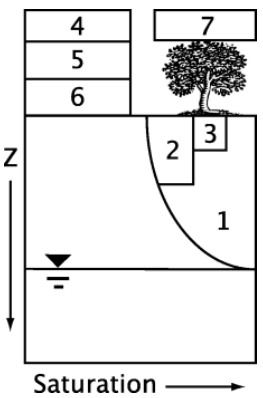
Figure 8. CLSM model structure and state variables including: ( 1 ) soil moisture; ( 2 ) root zone; ( 3 ) surface; ( 4 – 6 ) snow; and (7) canopy. From Foreman et al.